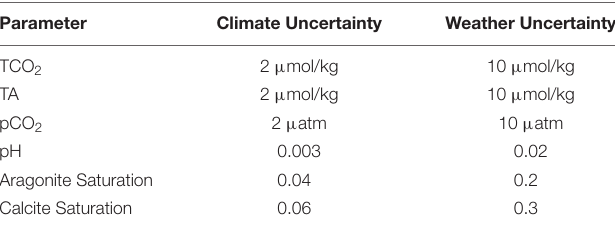
TABLE 1 | Recommended measurement uncertainties for climate and weather from Newton et al. (2015). Parameter Climate Uncertainty